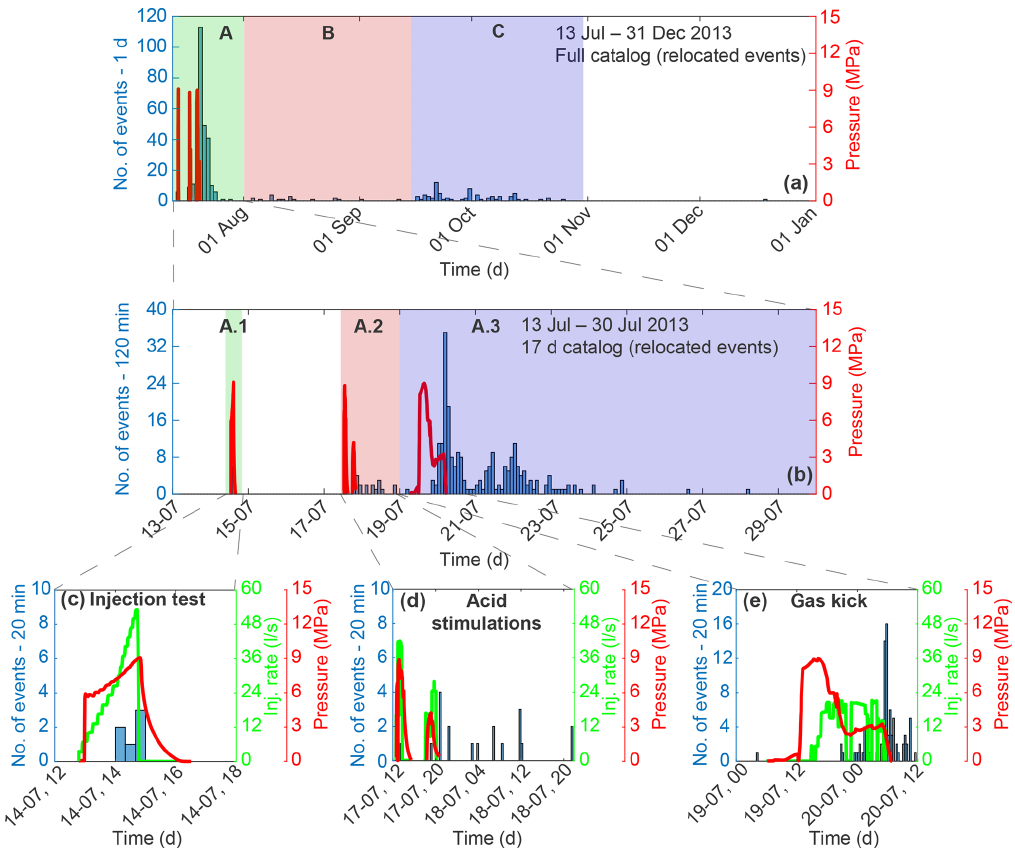
Figure 1. The St. Gallen induced seismicity sequence: (a) time series of the wellhead pressure in SG GT-1 and number of relocated events of the full catalog from July to the end of 2013. A: main seismicity sequence; B: more quiet post-injection period; C: seismic activity restarts due to cleaning and fishing operations. (b) Time series of the wellhead pressure in SG GT-1 and number of relocated events from 13 July to the end of July 2013. A.1: injection test; A.2: acid stimulations; A.3: gas kick and well control measures. (c, d, e) Time series of the injection rates and wellhead pressure in SG GT-1, as well as the number of relocated seismic events for the (c) injection test (14 July), (d) acid stimulations (17 July), and gas kick including the well control injection (19–20 July). The full relocated catalog is taken from Diehl et al.